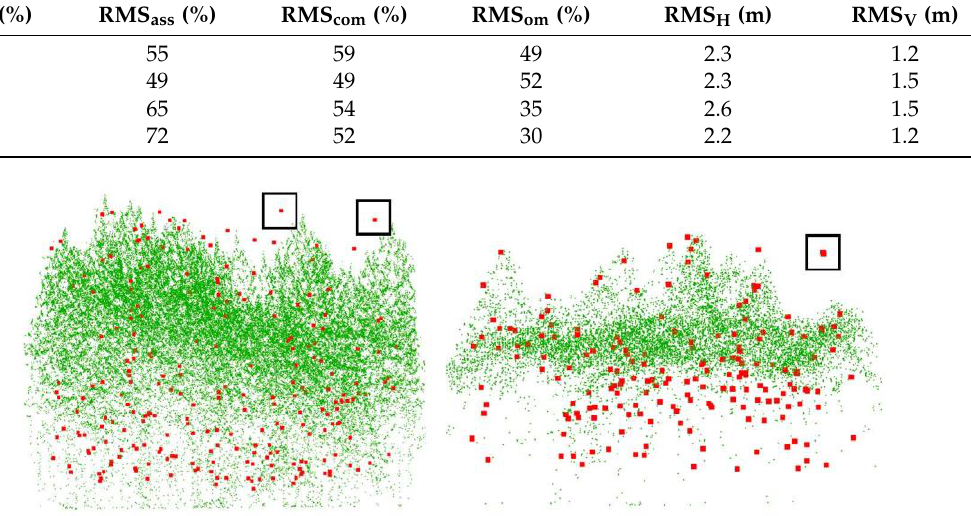
Figure 5. The point clouds and tree positions of plots 7 and 10. The green points are tree point clouds and the red points are reference tree top positions. Table 2. Detection performance for each plot.